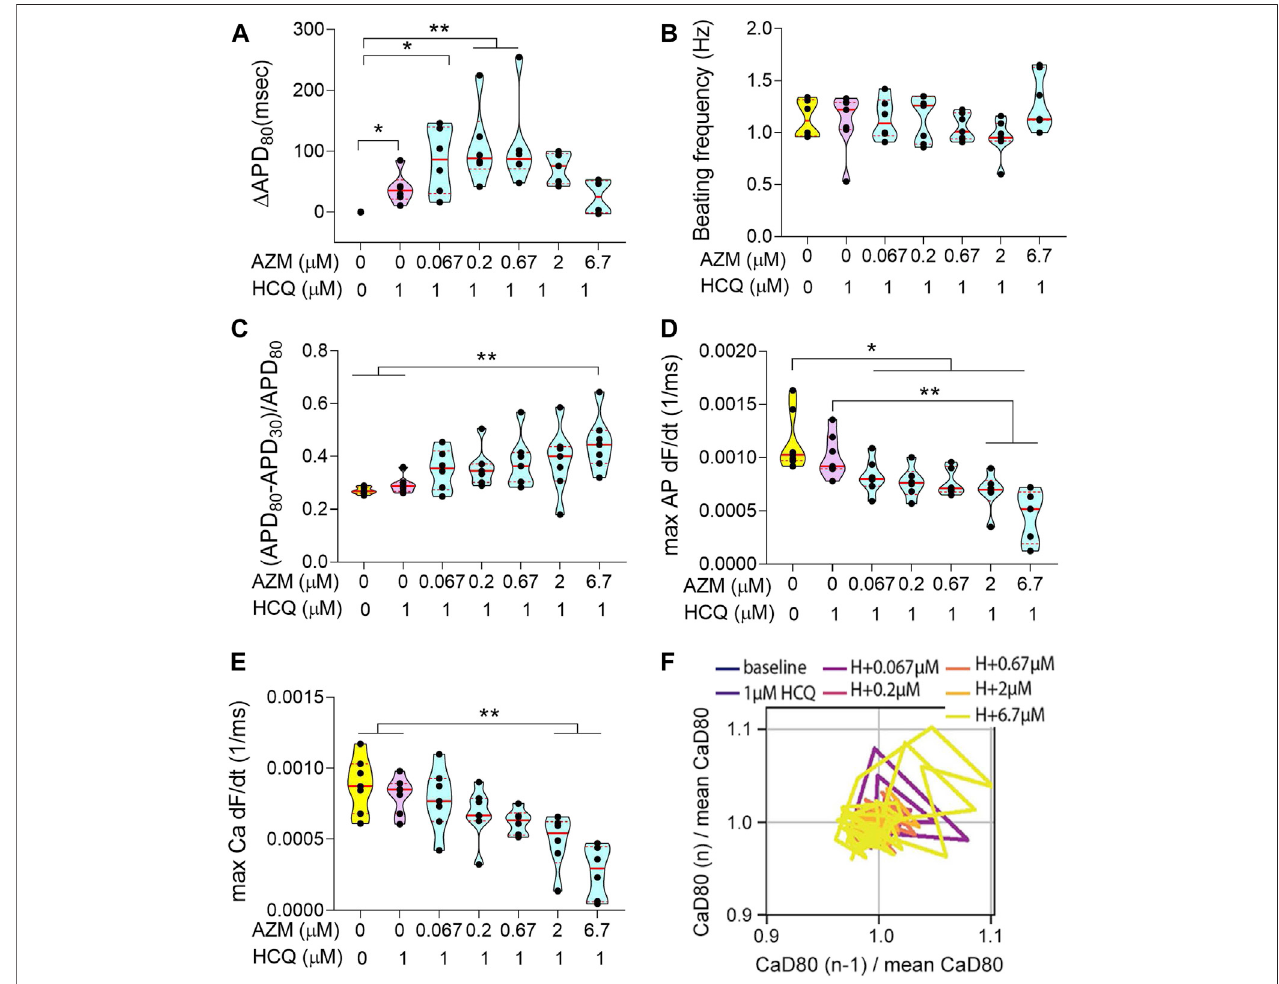
FIGURE 5 | Electrophysiology analysis of acute combination of HCQ and AZM exposure. (A) Violin plot depicting the change in APD 80 in paced tissues over increasing doses. Values were normalized tobaseline0 μ M of each respective tissue. (B) Graph showing spontaneous beating frequency in Hz. (C) Triangulation values of spontaneous action potential traces. (D) Violin plot showing the action potential maximum upstroke velocity, calculated as the maximum of the upstroke slope of paced traces. (E) Graph describing the maximum upstroke velocity of paced calcium transient traces. (F) Representative Poincaré plot showing instabilities in calciumtransientdurationinresponsetoHCQ+AZMpolytherapy(datafromspontaneoustraces).AlltissuesanalyzedwerewithininclusioncriteriaofAPD 80 < 500msat baseline. Statistics run were one-way ANOVA with multiple comparison to baseline 0 and 1 μ M HCQ and Dunnett ’ s post-hoc analysis. Unpaired t -test comparison with Welch ’ s correction between 0 and 1 μ M HCQ were performed to con fi rm observations seen in Figure 2 , t -test only showed signi fi cance for A. * p < 0.05; ** p < 0.01; *** p < 0.001,*** p < 0.0001.